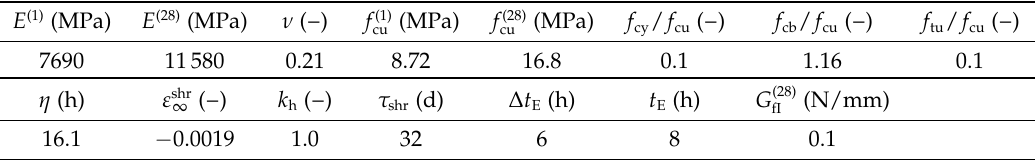
Table 2. Material parameters for the Meschke model.